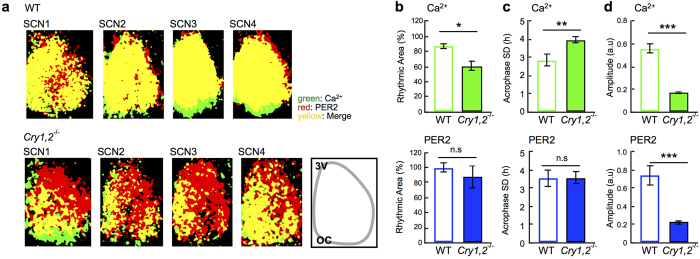
Statistical comparison of the network rhythmicity and coherence.(a) Rhythmic areas are compared by depicting pixels with significant Ca2+ rhythms in green, those with significant PER2 rhythms in red, and those with both rhythms in yellow. All SCN slices examined are shown for wild-type (upper) and Cry1,2−/− SCN (lower). The percentage of the rhythmic areas in the SCN was estimated as the ratio of statistically rhythmic pixels (by Percent Rhythm, p < 0.01) (see Methods) to total pixels blighter than background level (>mean + 5 SD). (b) Percentage of the rhythmic area of Ca2+ (upper) and PER2 (lower) rhythms in wild-type and Cry1,2−/− SCN. (c) The SD of acrophase for Ca2+ (upper) and PER2 rhythms (lower) in wild-type and Cry1,2−/− SCN. (d) Amplitude of the Ca2+ (upper) and PER2 (lower) rhythms in wild-type and Cry1,2−/− SCN. Amplitude and acrophase SD were obtained using pixel-based mapping software, *p < 0.05, **p < 0.01, ***p < 0.001, n.s (not significant). Wild-type (WT): n = 4 slices, Cry1,2−/−: n = 4 slices.